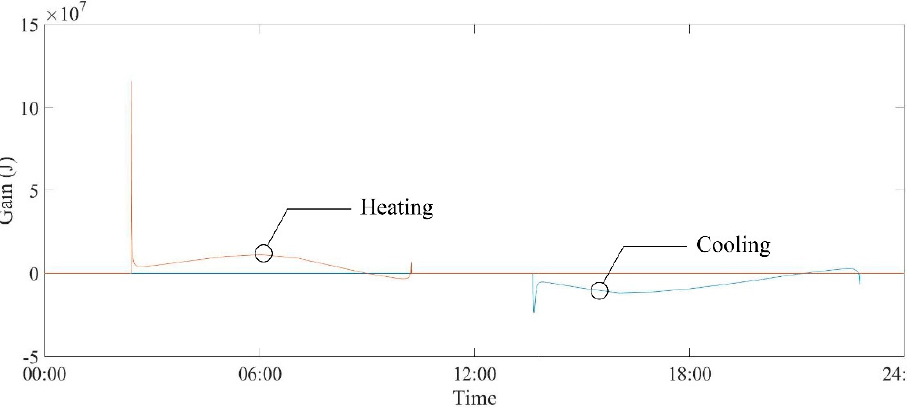
Figure 13. Energy use by ANN at an abnormal condition.